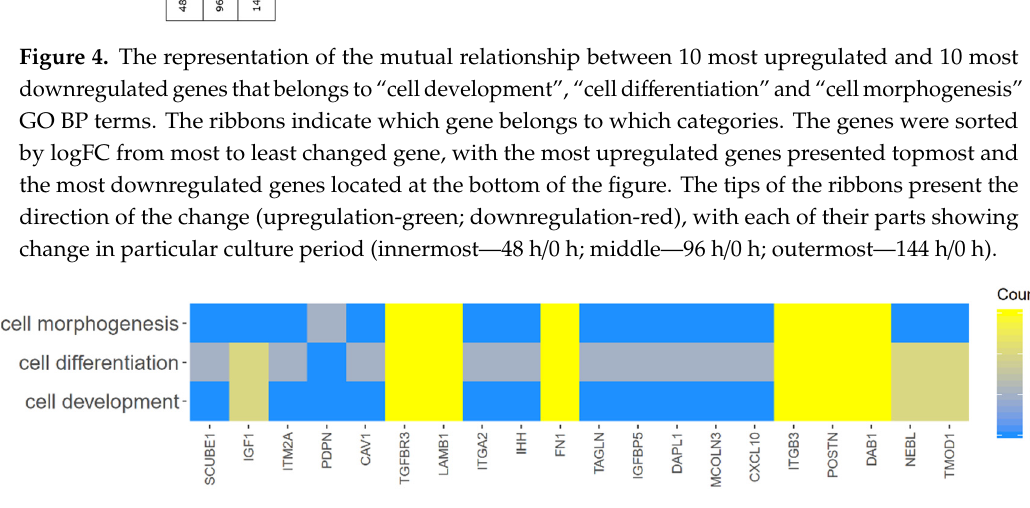
Figure 5. Heatmap showing the gene occurrence between 10 most upregulated and 10 most downregulated genes that belongs to “cell development”, “cell differentiation” and “cell morphogenesis” GO BP terms.